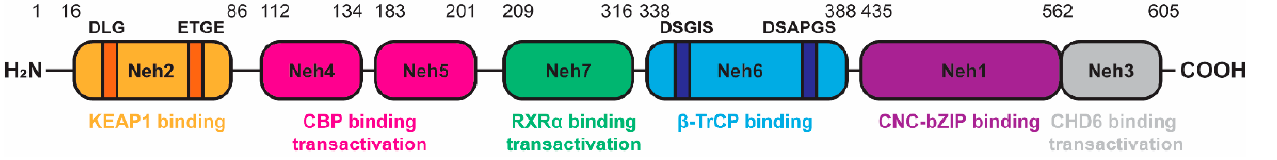
Figure 1. NRF2 protein structure with seven NRF2-ECH homology (Neh) domains, each permitting direct protein–protein interactions with key NRF2 regulators. Numbers correlate with the NRF2 amino acid sequence. Four Neh domains (Neh4, Neh5, Neh7 and Neh3) are transactivation domains. Neh2 harbours two binding motifs for KEAP1 interactions with markedly stronger affinity at ETGE than DLG. Neh6 similarly contains two degron sequences that facilitate β -TrCP binding; DSGIS and DSAPGS. Both KEAP1 and β -TrCP are negative regulators of NRF2 and facilitate its proteasomal degradation. Neh1 is a conserved domain with other bZIP proteins and permits the dimerisation of NRF2 with sMAF proteins for downstream binding to genetic targets.